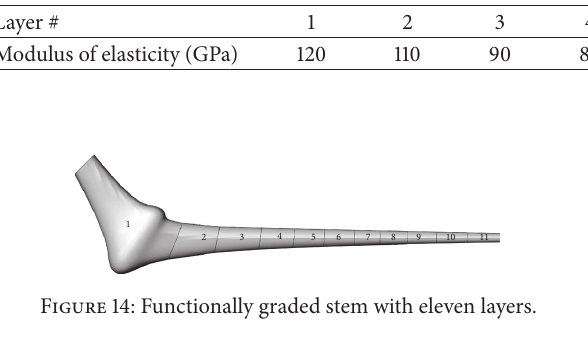
Table 3: Modulus of elasticity along the length of the functionally graded implant.